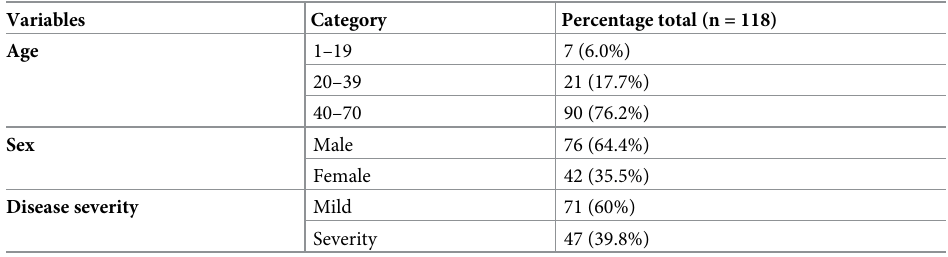
Table 1. Demographic data. The demographic data of 118 participants from the SARS COV2